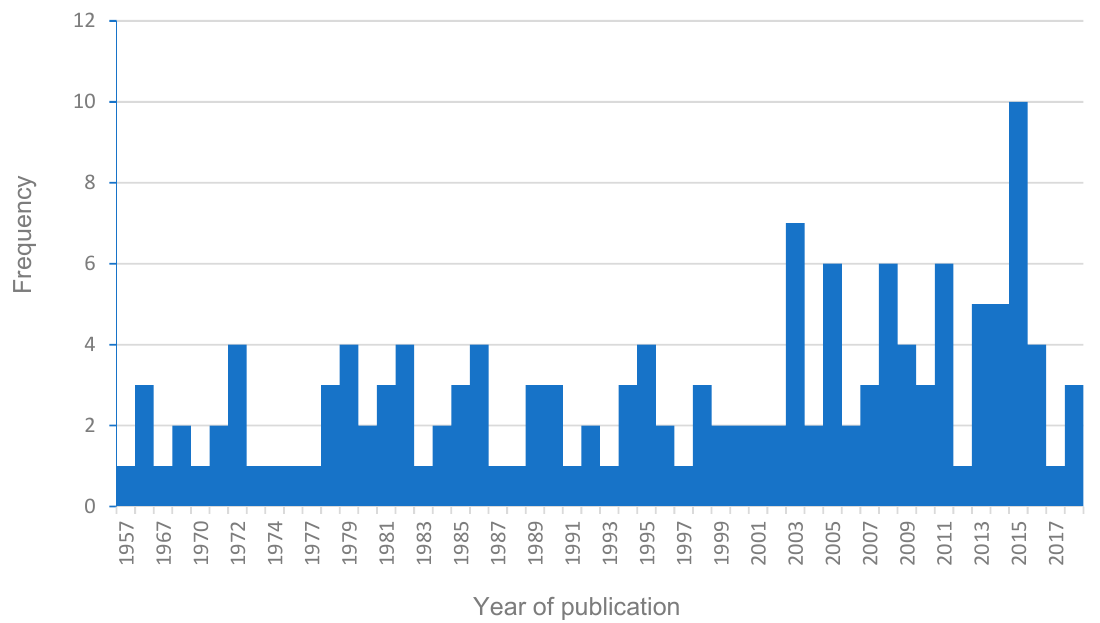
Figure 2. Number of publications reporting viral diseases in African ungulates per year from 1957 to 2018. Table 1. The proportion of different types of publications reporting on viruses/viral diseases in African